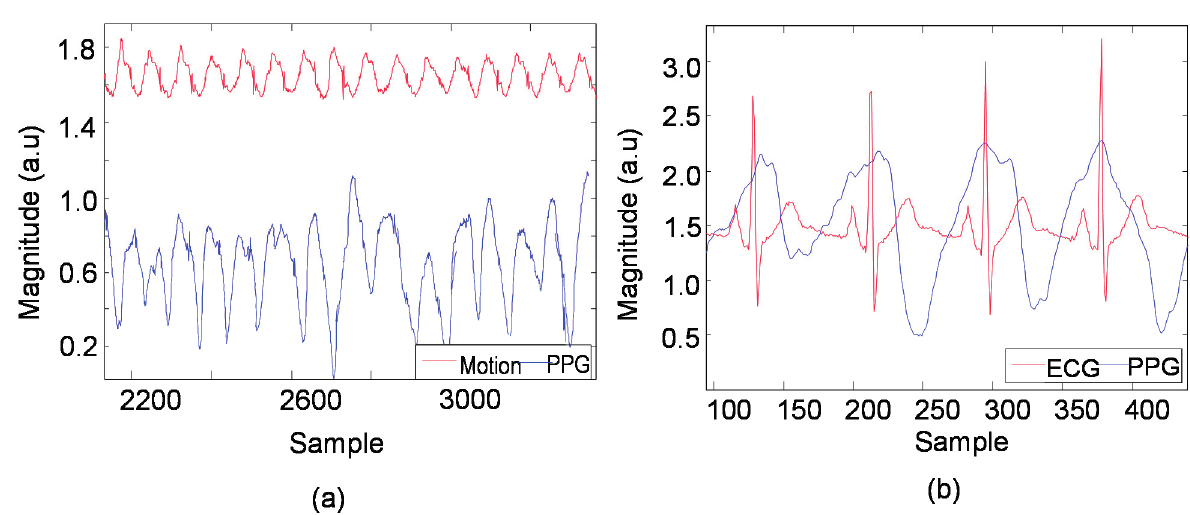
Figure 16. Recovery of PPG signals through motion artefact reduction (MAR) and synchronizing these PPG signals with Polar (ECG). ( a ) Recovering PPG with reference motion; ( b ) Synchronization between recovered PPG and golden standard